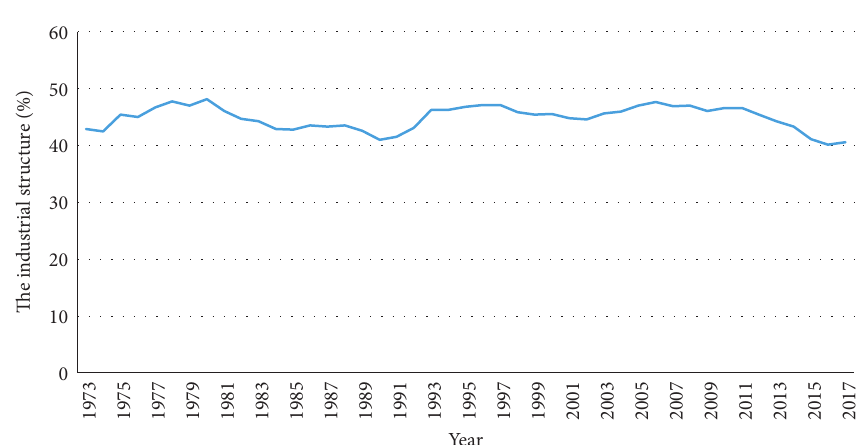
Figure 4: The proportion of secondary industry in Chinese GDP from 1973 to